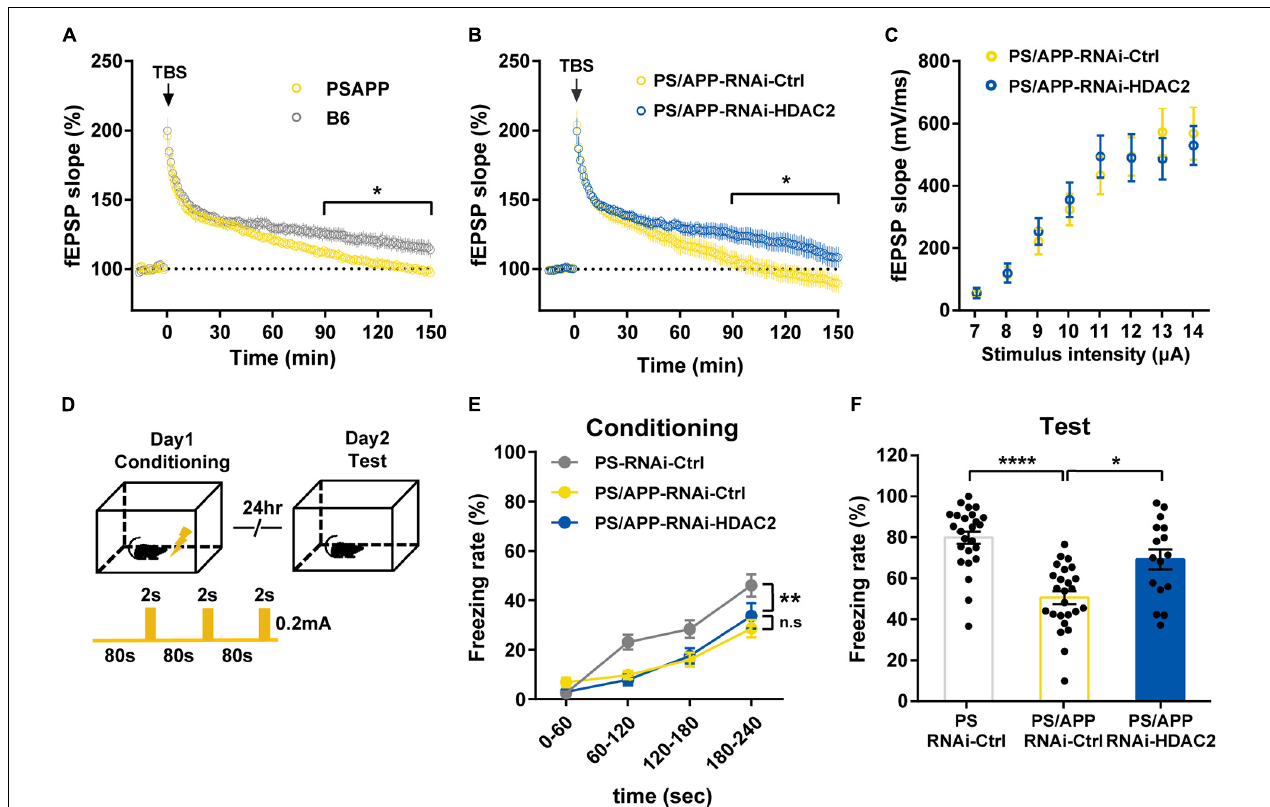
FIGURE 3 | Histone Deacetylase 2 silencing ameliorated the impairment of synaptic plasticity and memory in PS/APP mice. (A) LTP from PS/APP mice decayed to the baseline. (B) LTP induced by 4 trains of TBS. HDAC2 silencing improved the decay observed in PS/APP mice. (C) Input/output relationships from PS/APP mice injected with AAV-RNAi-HDAC2 or AAV-RNAi-Ctrl. There was no significant difference. (D) Schematic of the experimental procedure of fear conditioning test. (E) Freezing rate at conditioning trial. PS mice and PS/APP mice showed progressive increase of freezing behavior. (F) Freezing rate at test trial. PS/APP mice showed decrease in freezing behavior. HDAC2 silencing improved the decreased freezing behavior of PS/APP mice. All data are presented as mean ± SEM. * p < 0.05, ** p < 0.01, and **** p < 0.0001. Two-way repeated measured ANOVA for (A,B,E) , two-way ANOVA for (C) , Dunn’s multiple comparisons test for (F)